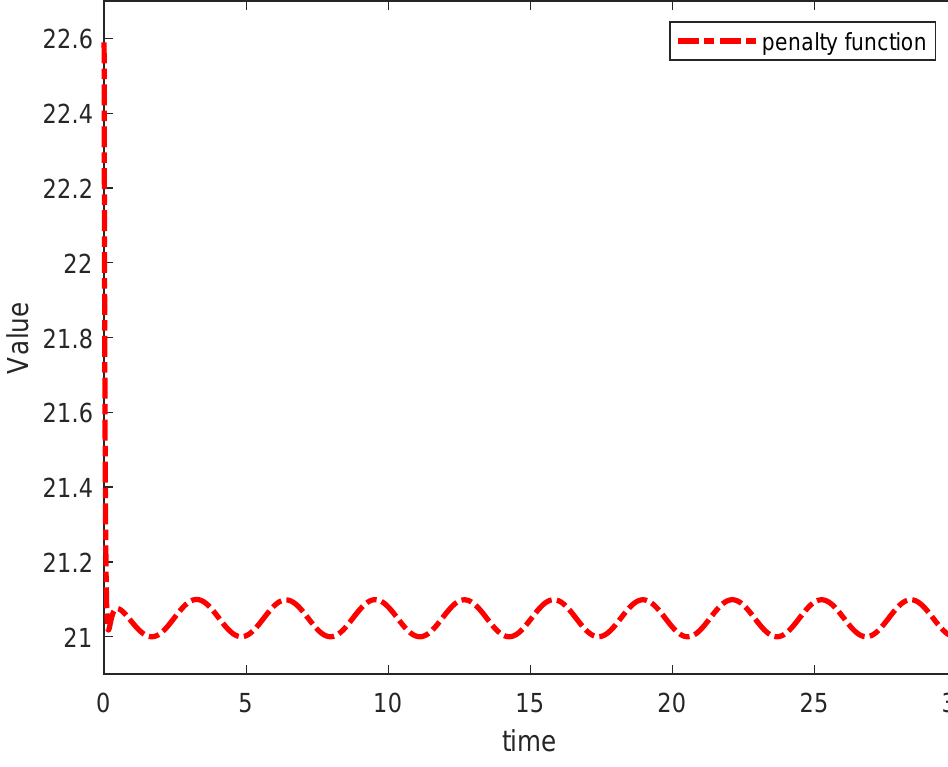
Figure 16. The value of penalty function based on the algorithm proposed in this